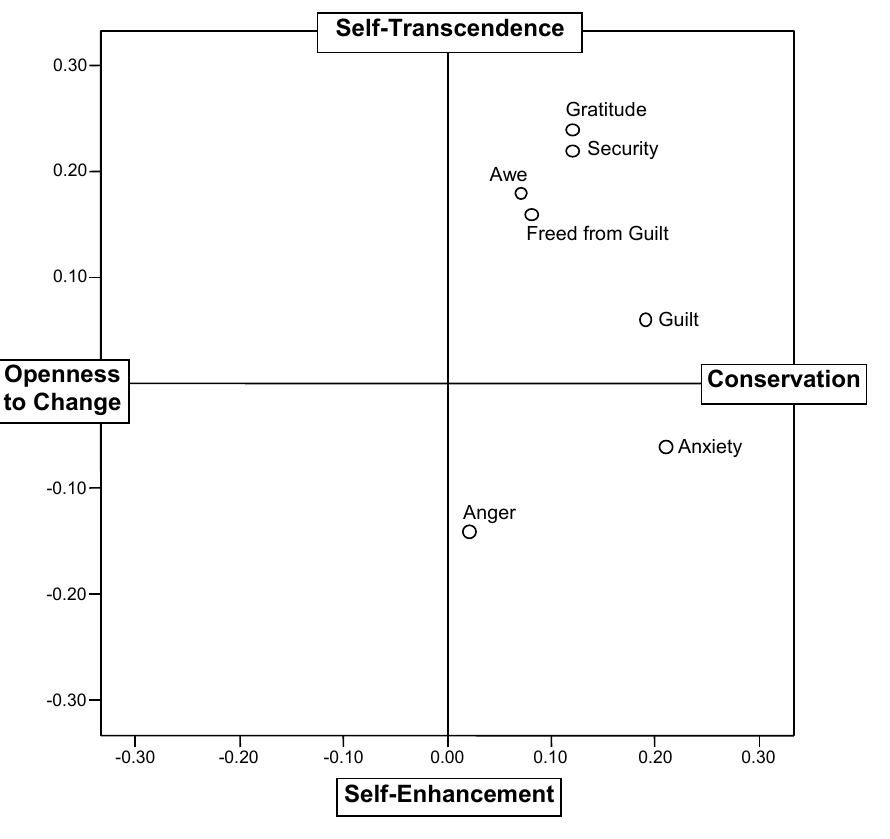
Figure 3. Correlation plot of emotions toward God with the two dimensions of the value circle. The emotion of guilt in relation to God is plotted in the segment of tradition and correlated with the dimension of self-transcendence vs. self-enhancement by r = 0.06 and r = 0.19 with the dimension of conservation vs. openness to change. Anxiety toward God is plotted in the segment of security values and correlated with the dimension of self-transcendence vs. self-enhancement by r = − 0.06 and r = 0.21 with the dimension of conservation vs. openness to change. Anger toward God is plotted in the segment of power values and correlated with the dimension of self-transcendence vs. self-enhancement by r = − 0.14 and r = 0.02 with the dimension of conservation vs. openness to change. Table 2 shows the direct correlations of centrality of religiosity and the religious and political orientations with the emotions toward God. The higher correlations show a pattern well in line with their locations in the value